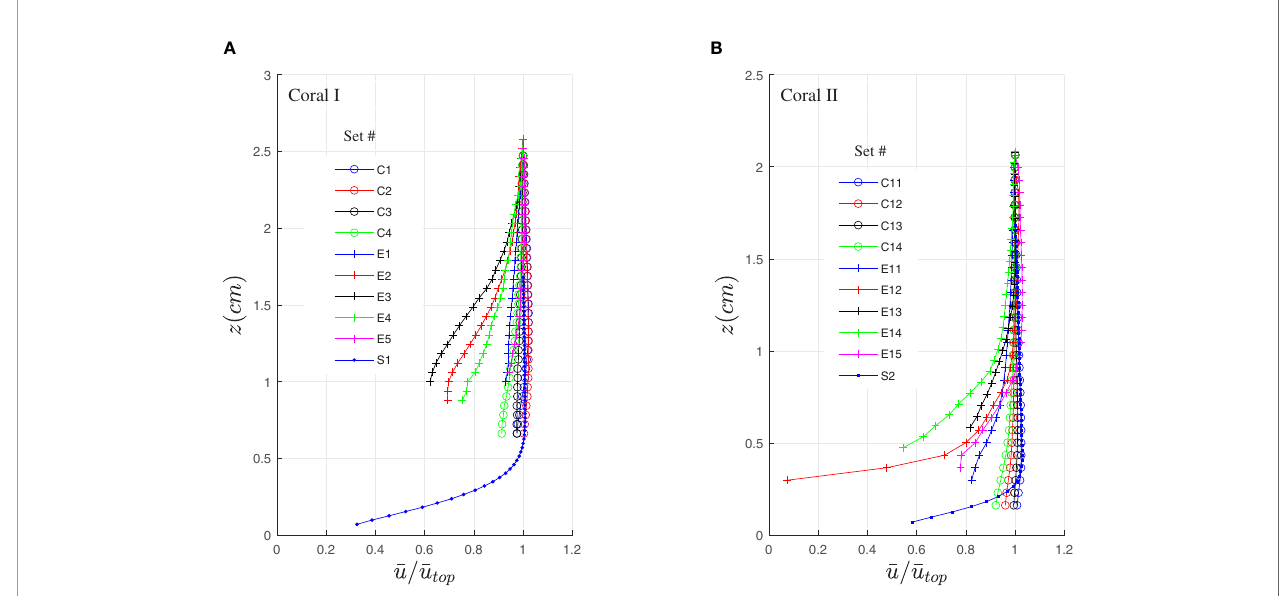
FIGURE 4 | Mean horizontal velocity, (cid:1) u = (cid:1) u top , above coral I (A) and coral II (B) versus height above the corals. Measurements were taken when the tentacles were contracted and extended. For comparison, the same measurements were obtained above a skeleton of D. favus in the laboratory. C- contracted, E- extended,